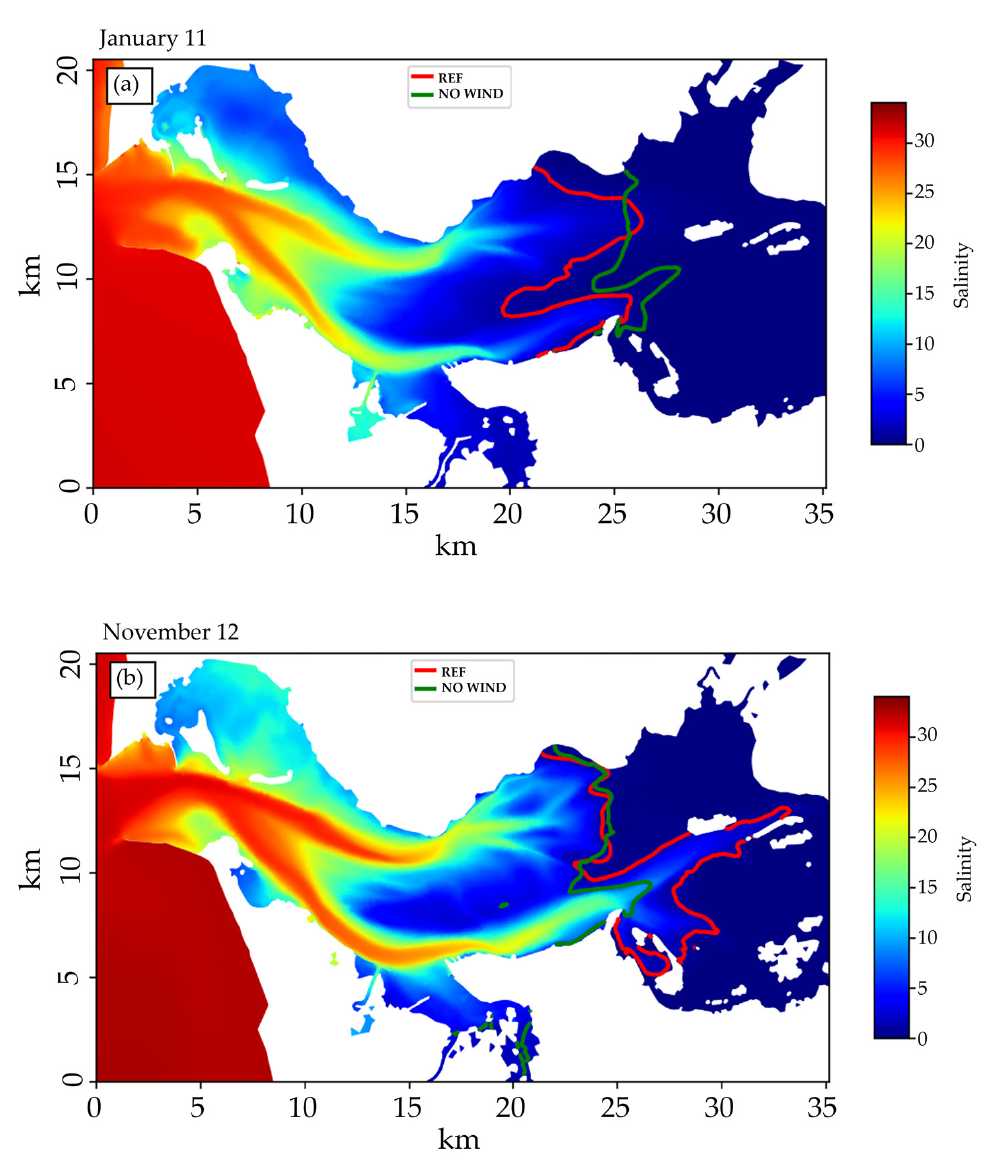
Figure 8. Maps of bottom REF salinity (psu), tidally averaged and centered on the day, with isolines of salinity values equal to 1 psu (red line). ( a ) Event of January and ( b ) event of November 2014. The green line indicates the 1 psu salinity for the NOWIND simulation.